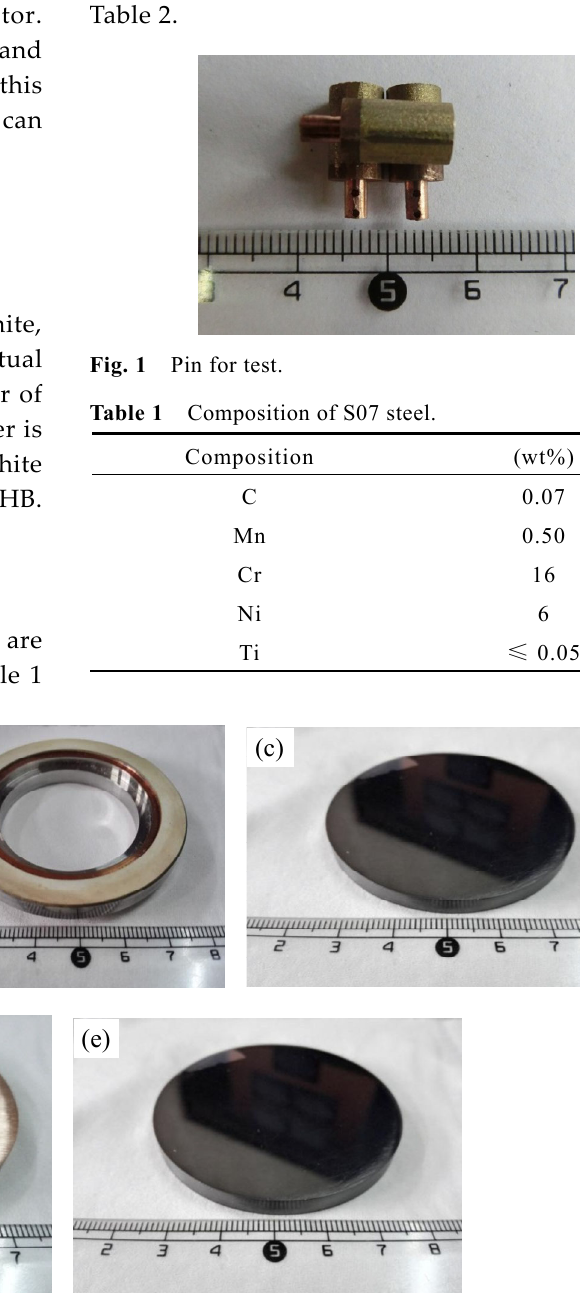
Fig. 2 Disk samples: (a) S07 steel disk (sample A), (b) alumina ceramic coating disk (sample B), (c) S07 steel disk with DLC film (sample C), (d) copper-chromium alloy disk (sample D), and (e) nickel-based calcium fluoride disk (sample